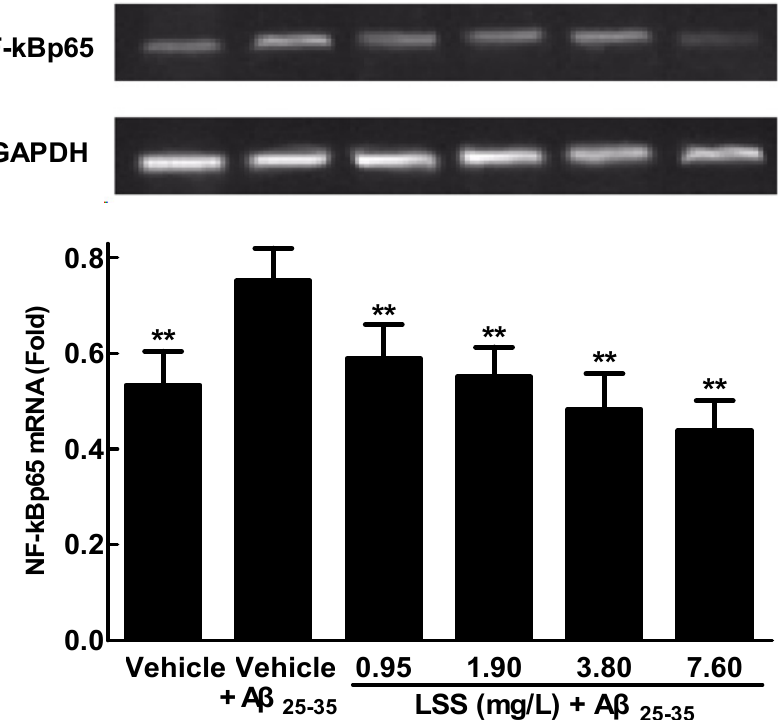
Figure 6. Effect of LSS on the mRNA expression of NF ‐κ Bp65 in PC12 cells treated with A β 25 ‐ 35 (20 μ mol/L). The results are representative of at least three independent experiments run in triplicate and expressed as mean ± SD. ** p < 0.01 vs. the cells treated with A β 25 ‐ 35 and vehicle.